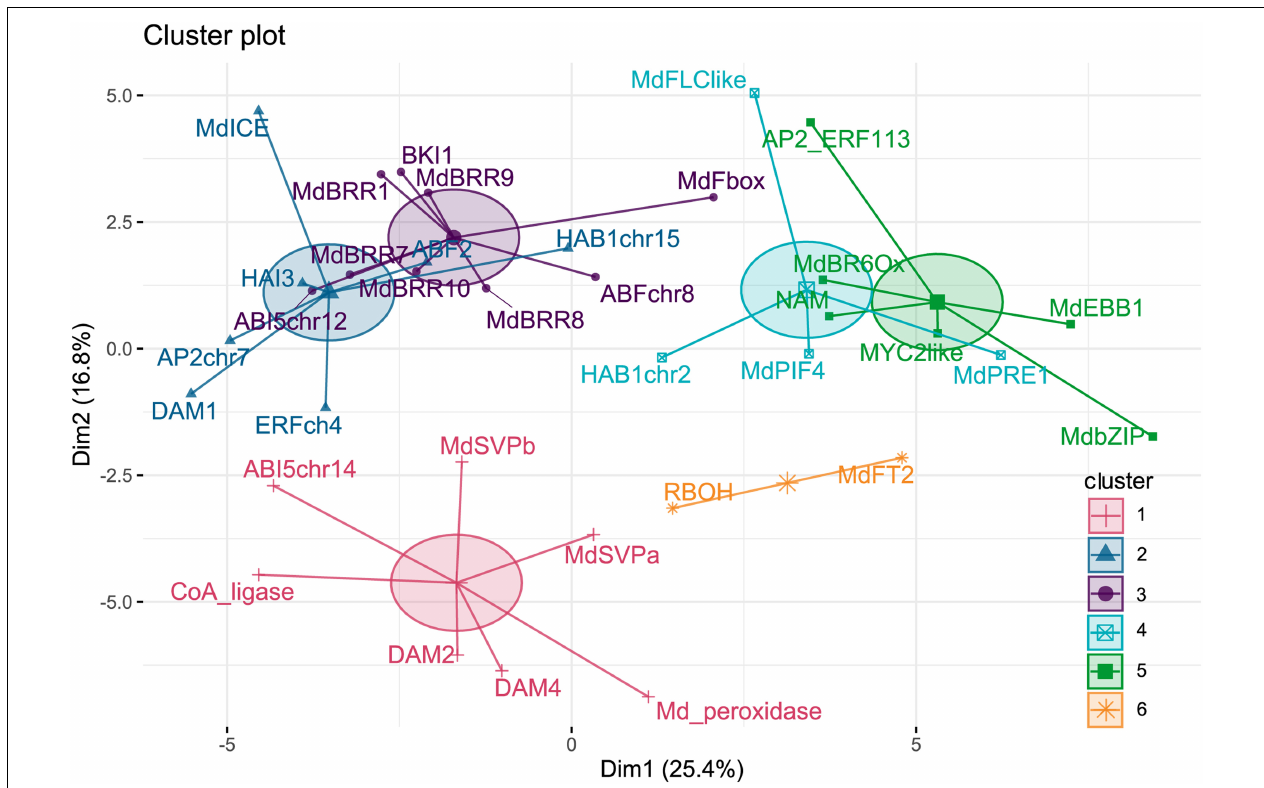
FIGURE 1 | Clusters of genes determined by k -means clustering of gene expression patterns. A total of 35 genes were clustered into six clusters according to their gene expression patterns across all